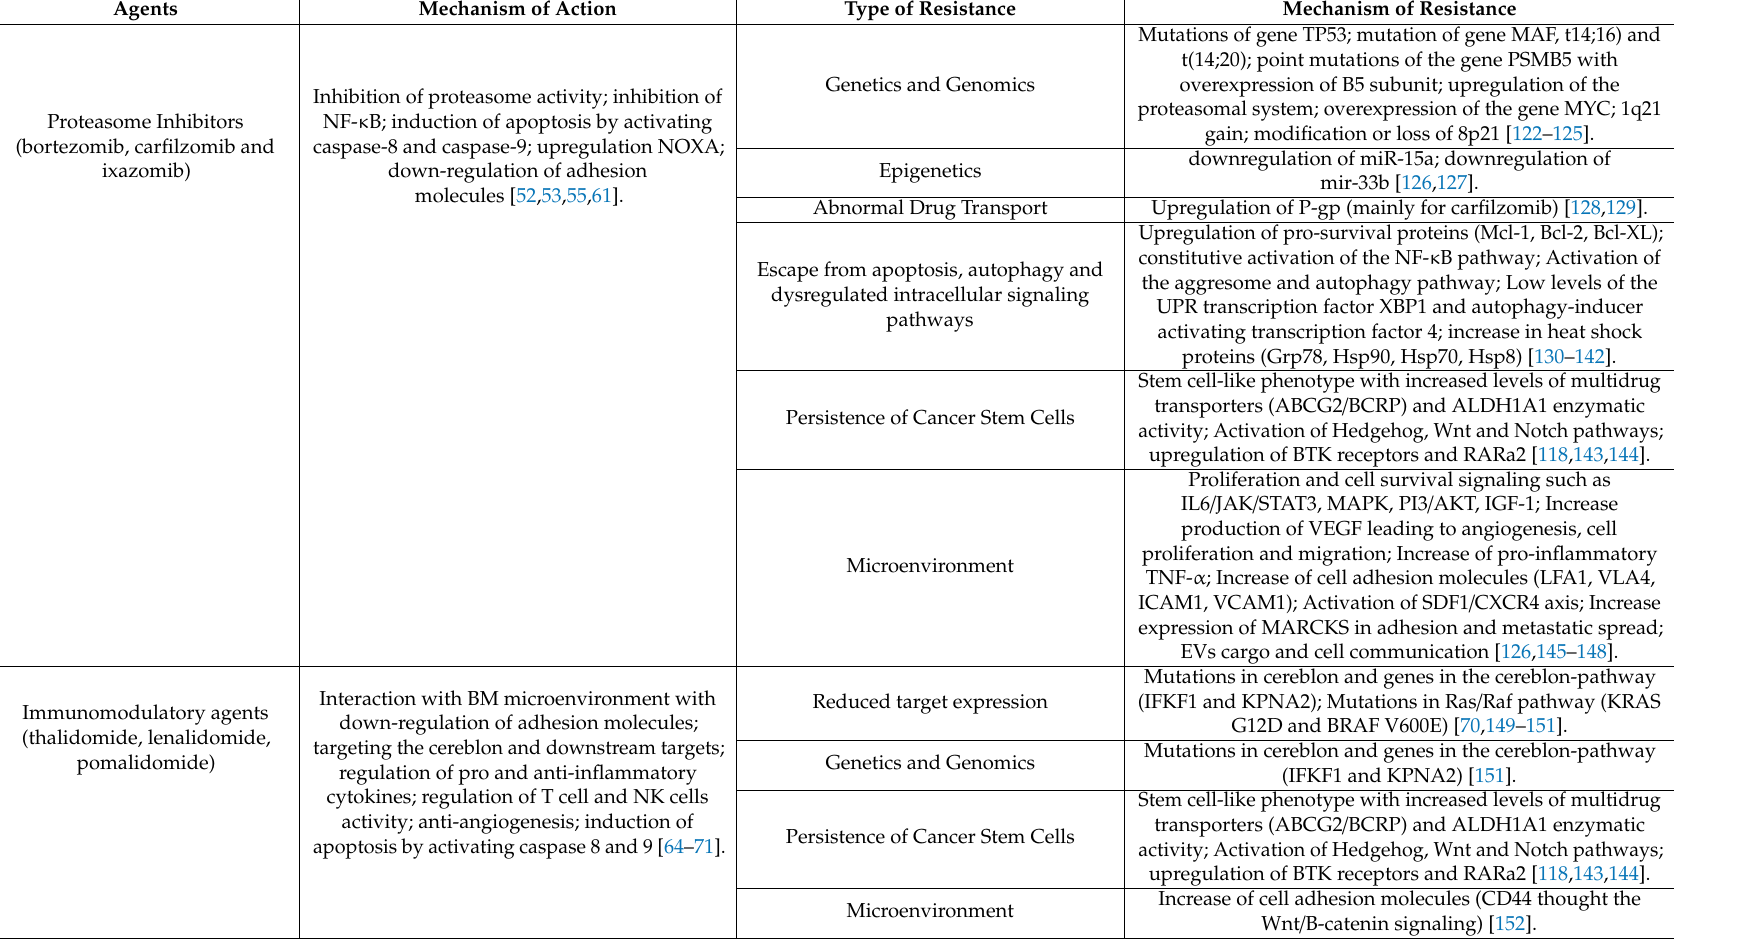
Table 1. Mechanisms of action and drug resistance of the most used classes of drugs in Multiple